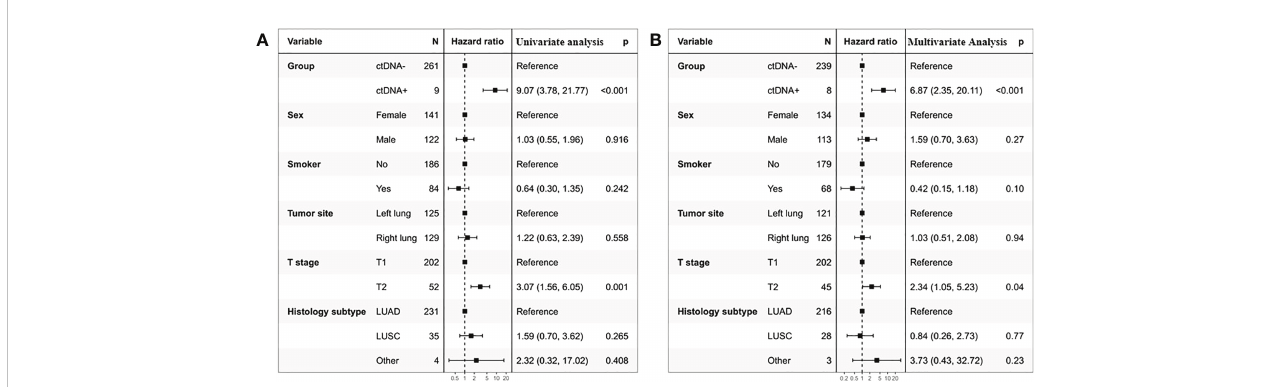
FIGURE 3 Univariate (A) and multivariate (B) Cox regression analyses of the association between patient ’ s characteristics and the probability of recurrence-free survival (RFS) in ctDNA-positive group.